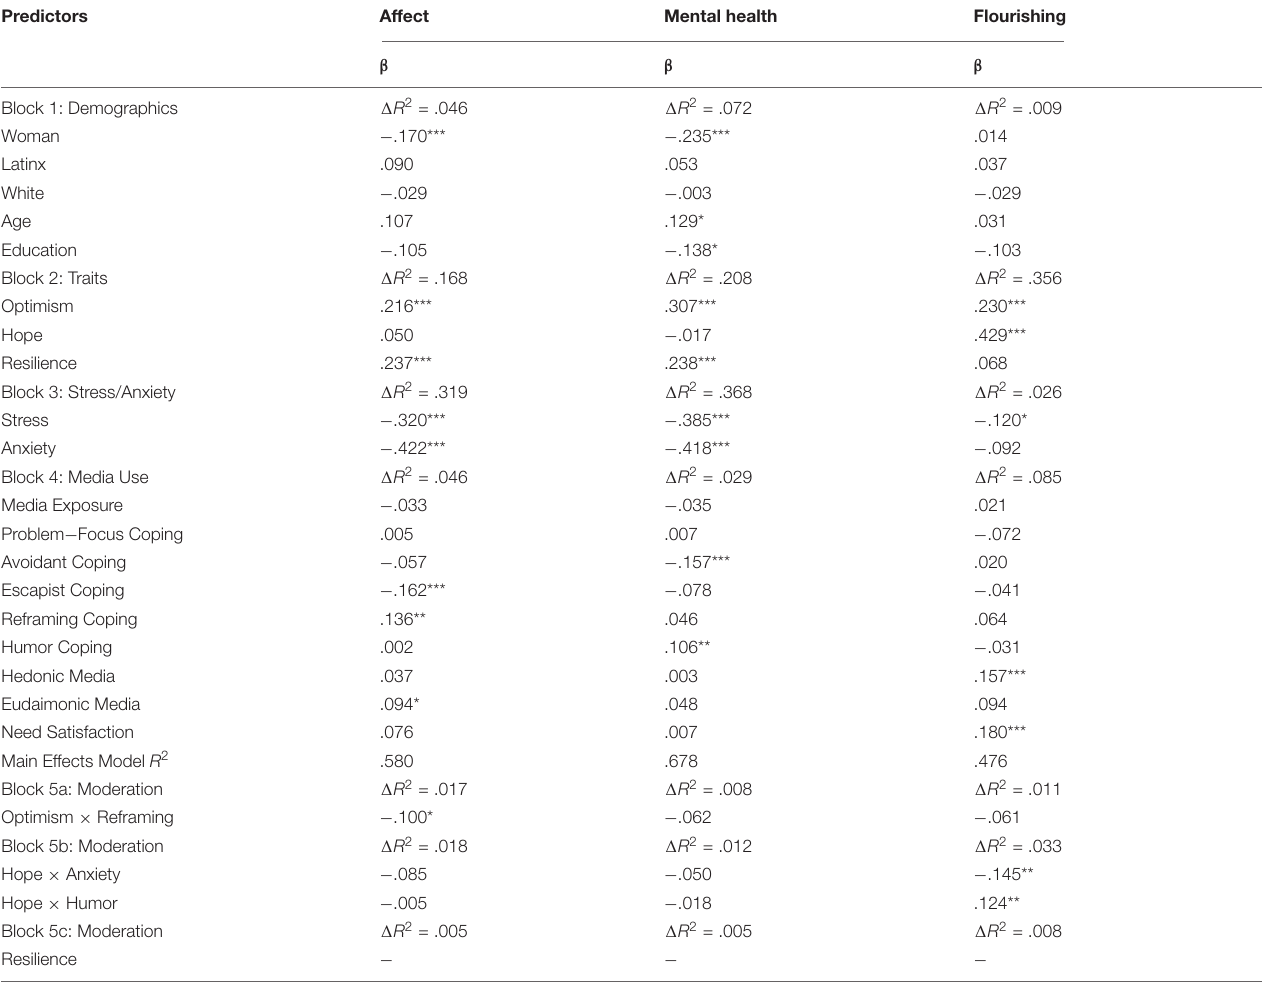
TABLE 6 | Associations of media use with affect, mental health, and flourishing.